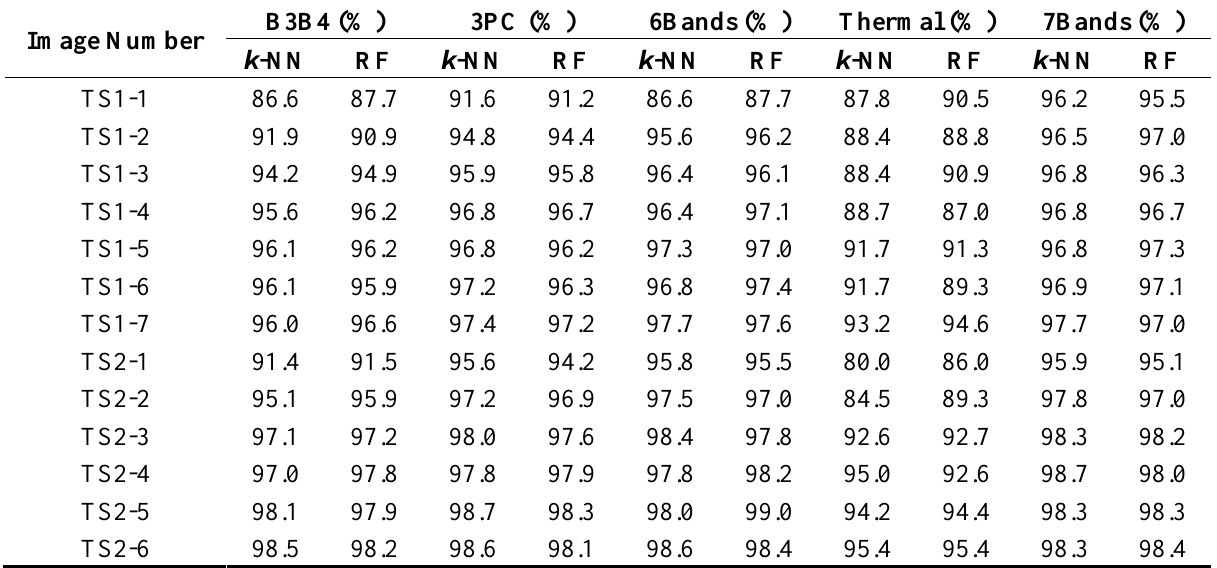
Table 2. Overall Accuracy of Level 1 classification assessed by the polygon-based CV method using five variants of time series of images: B3B4, the combination of band 3 and band 4; 3PC, the first three principal components of all bands; 6Bands, the combination of six bands; Thermal, the thermal band; and 7Bands, the combination of all seven bands.